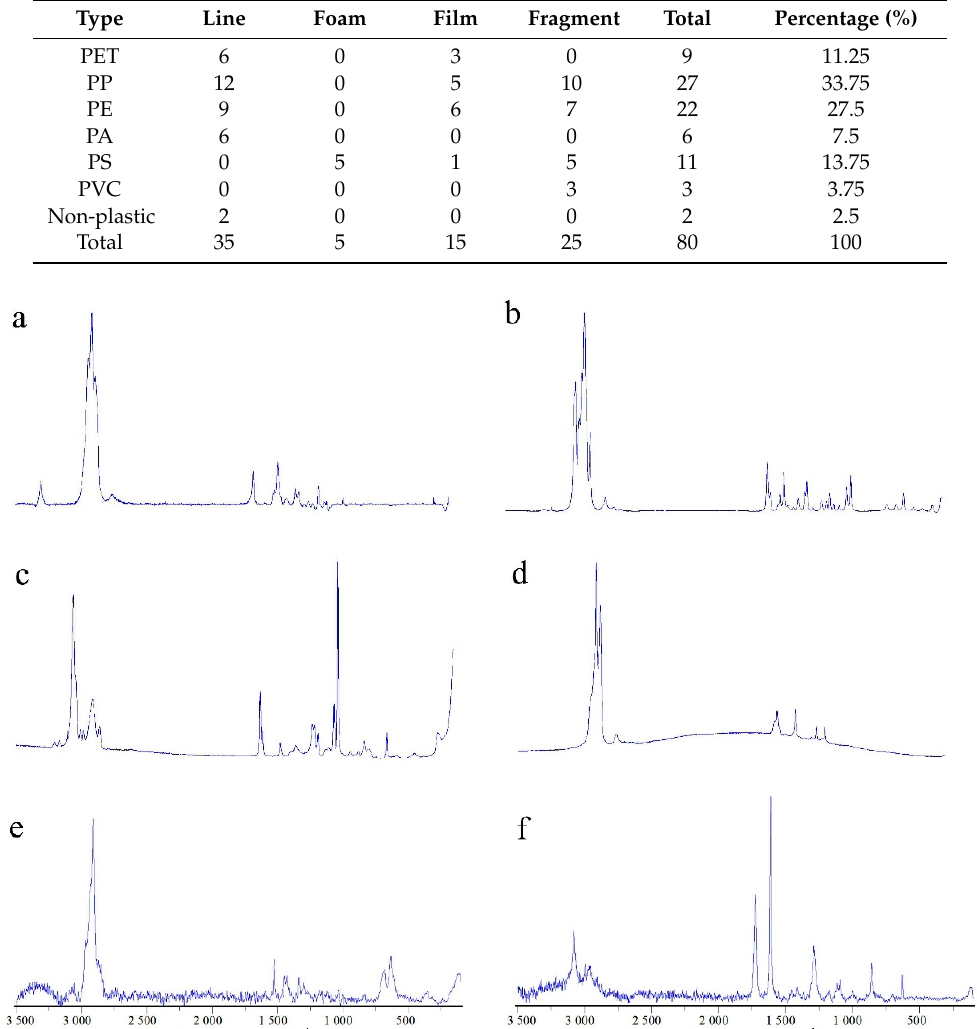
Figure 5. Typical micro-Raman spectra of the randomly selected microplastics. ( a ) PA, ( b ) PP, ( c ) PS, ( d ) PE, ( e ) PVC, ( f ) PET.